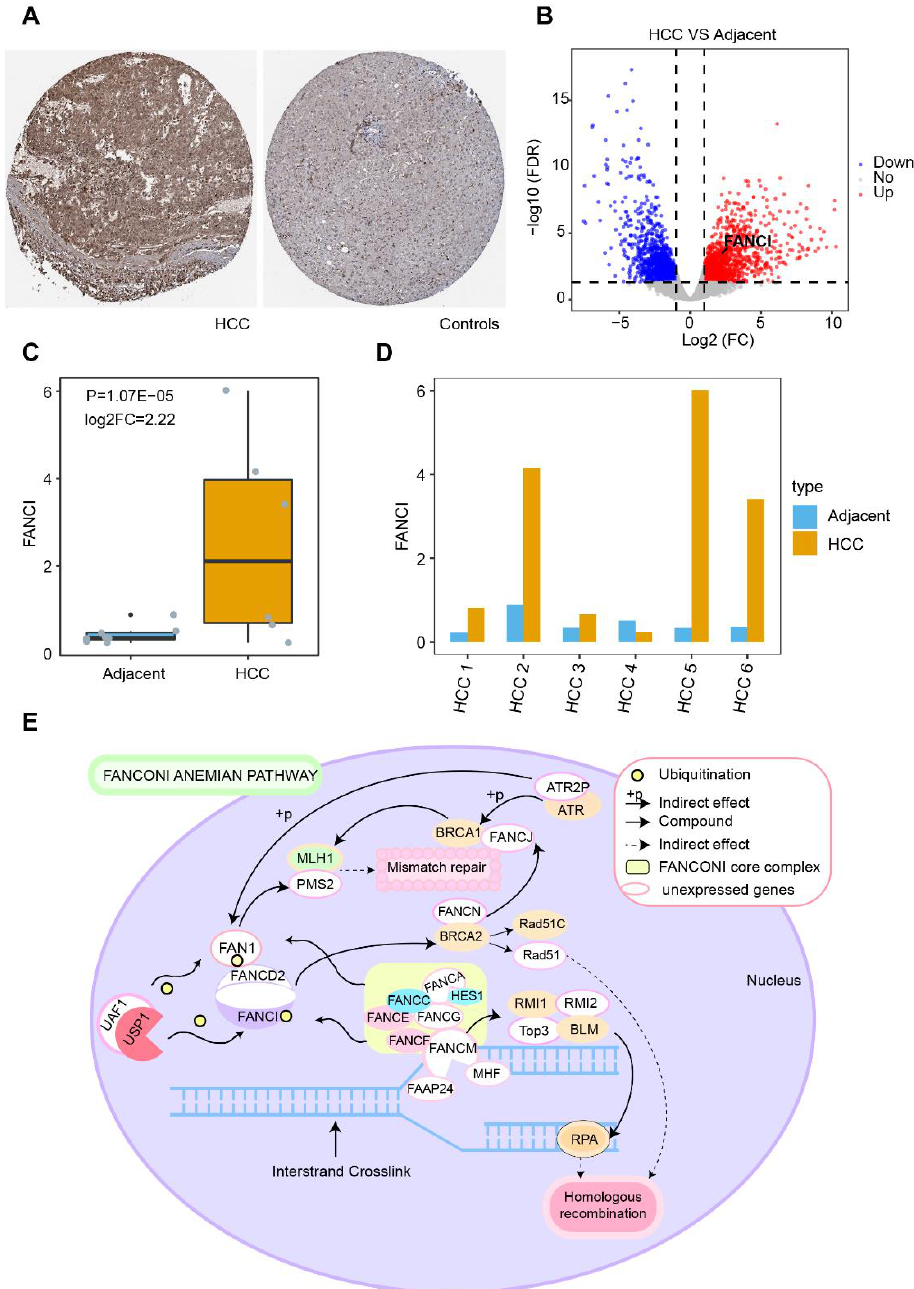
Figure 8. Potential regulatory mechanism of FANCI in hepatocellular carcinoma (HCC). ( A ) Expression of FANCI in HCC and normal tissues obtained from the Human Protein Atlas database. ( B ) DEGs in 6 HCC patients. Red indicates upregulated genes and blue, downregulated genes. ( C ) Expression of FANCI in HCC compared to adjacent obtained from 6 HCC patients. ( D ) Expression of FANCI in 6 HCC patients, respectively. ( E ) Role of FANCI in the Fanconi anemia pathway.